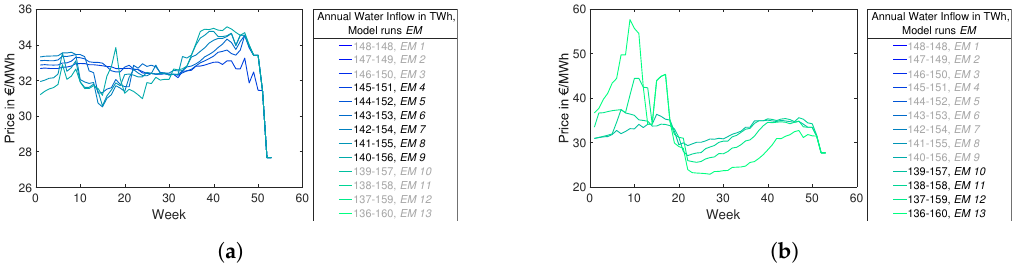
Figure 9. Impact of uncertainty on electricity prices: Realizing water inflow is the expectation value of the inflow scenarios. ( a ) impact of uncertainty on electricity prices: Model Runs EM 4–9; ( b ) impact of uncertainty on electricity prices: Model Runs EM 10–13.